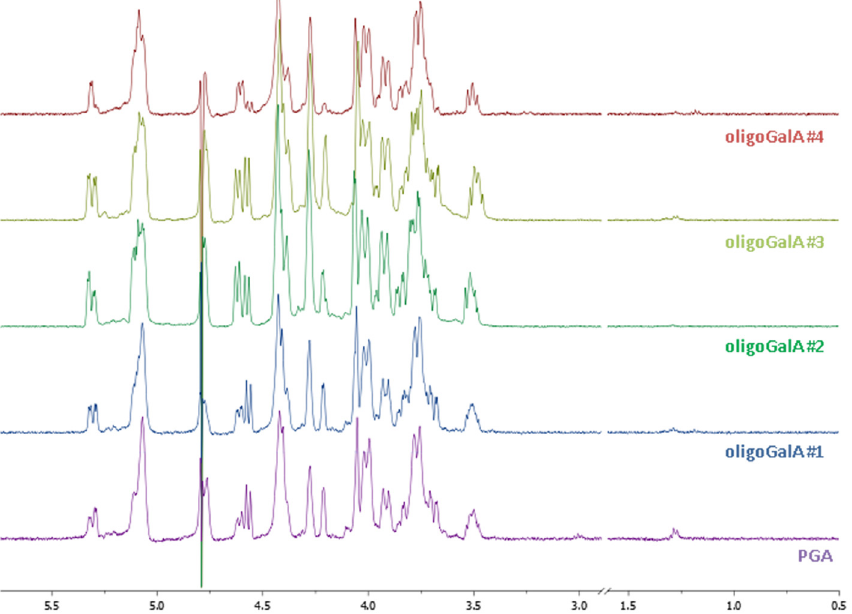
Figure 4. 1 H NMR (400 MHz) spectra in D 2 O of polygalacturonic acid (PGA) and